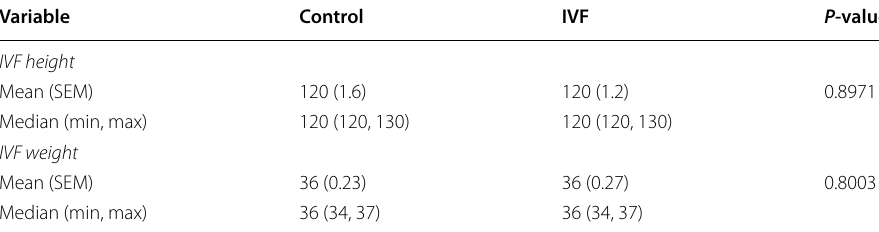
Table 2 Baseline height and weight of control and IVF groups